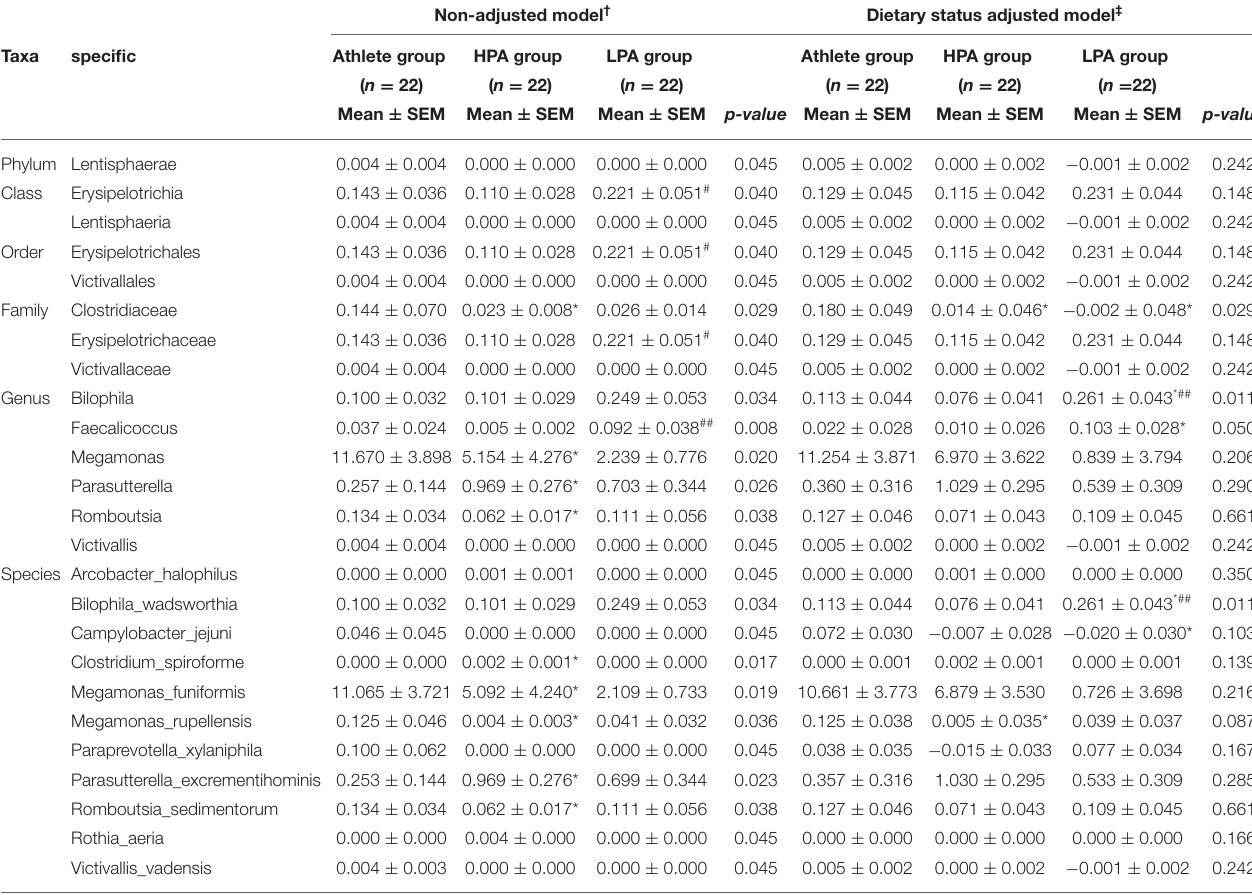
TABLE 3 | Phylotypes with significant difference among athletes and young adults before and after adjusting dietary status.